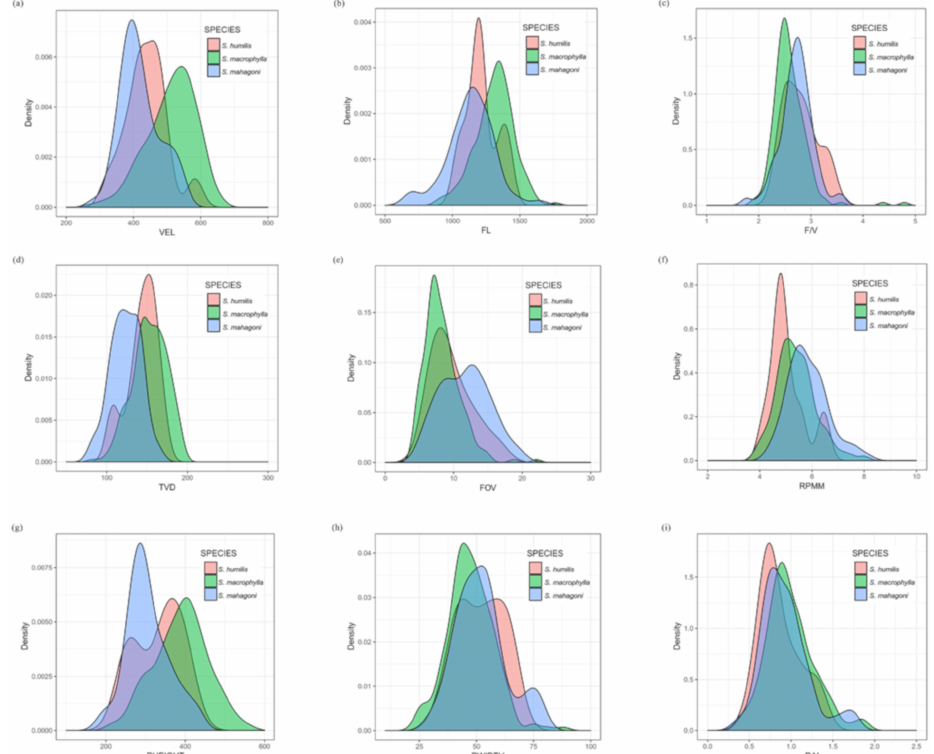
Figure 2. Smoothed data density histograms of the nine characters: ( a ) VEL, ( b ) FL, ( c ) F / V, ( d ) TVD, ( e ) FOV, ( f ) RPMM, ( g ) RHEIGHT, ( h ) RWIDTH, ( i )